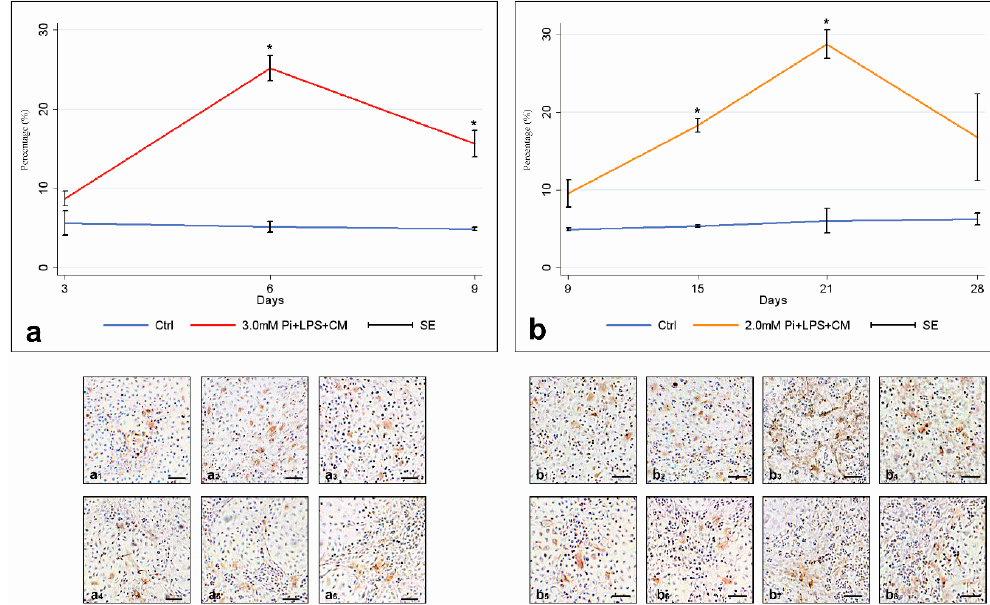
Figure 2. Percentages of cPLA2 α‐ immunopositive AVICs. ( a ) Percentages of immunopositive cells in 3 ‐ to 9 ‐ day ‐ long control and metastatic calcification ‐ like cultures. Data are shown as mean ± SE. Statistically significant values are indicated with asterisks ( p < 0.05). ( b ) Percentages of